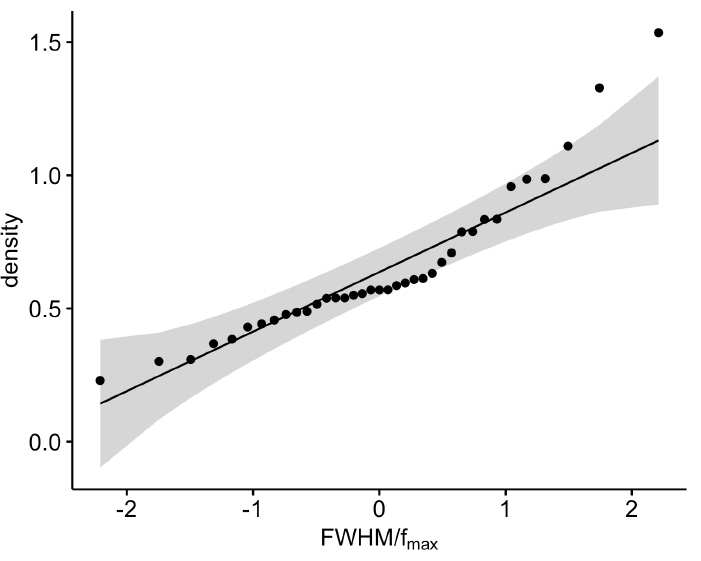
Figure 12. QQ nomality plot of FWHM / f max values of Table 3 for the shuffled time series. Table 4. Date-periods of Table 2 for which: (a) the PM 10 system is out of stochastic behaviour; (b) BE is below 2.0 and TE below 1.18; (c) points a and b are commonly found by 3 or more monitoring stations of Table 1; (d) FWHM / f max > 1.2 for the raw series or FWHM / f max > 1.1 for the shuffled series. Raw symbolises the FWHM / f max of the raw series and Shuffled of the shuffled series, respectively. Station Raw